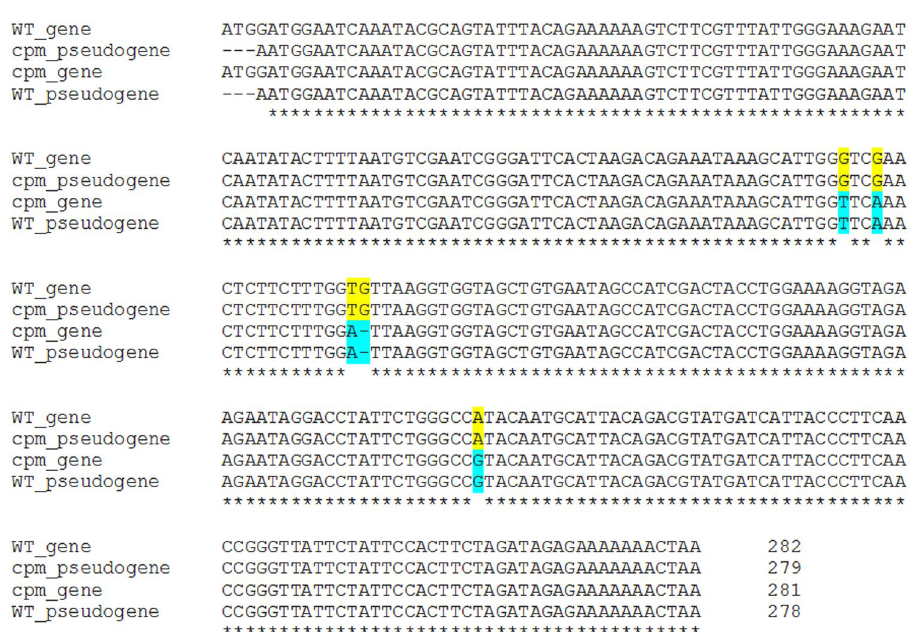
Figure 7. Alignment of rpl23 gene and rpl23 pseudogene sequences of wild type and polymorphic cpm